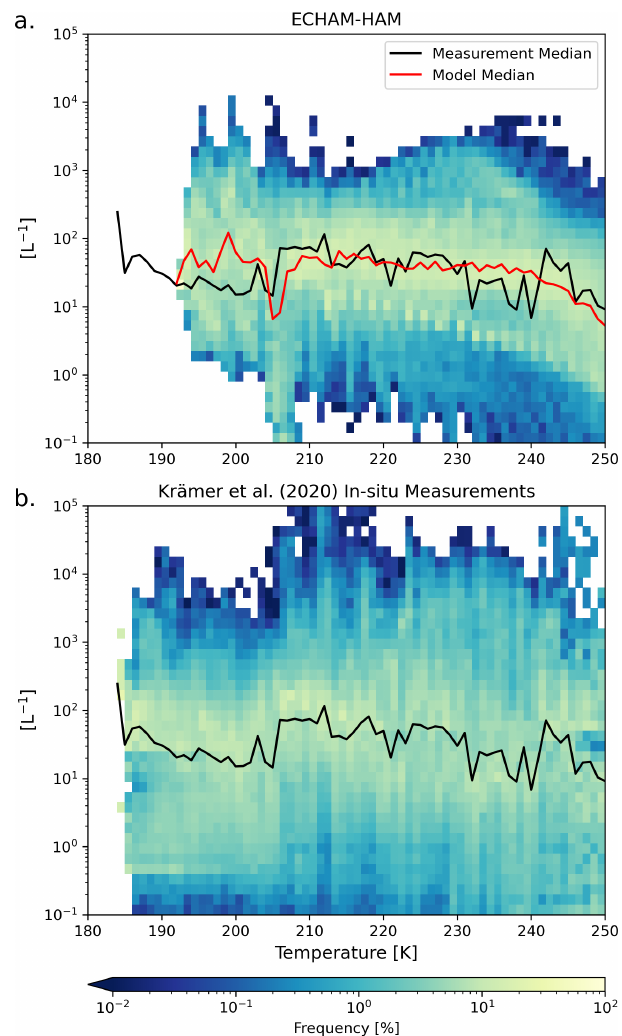
Figure 2. ICNC (L − 1 ) frequency diagrams for ice crystals with a diameter of at least 3µm as a function of temperature between 180 and 250K binned like in Krämer et al. (2020) for every 1K. The 5-year global mean data from the model are plotted in panel (a) and the compilation of in situ flight data from Krämer et al. (2020) is plotted in panel (b) . The red line in the upper plot represents the binned median ICNC value of the model data, and the black line in both plots is the same value for the observational